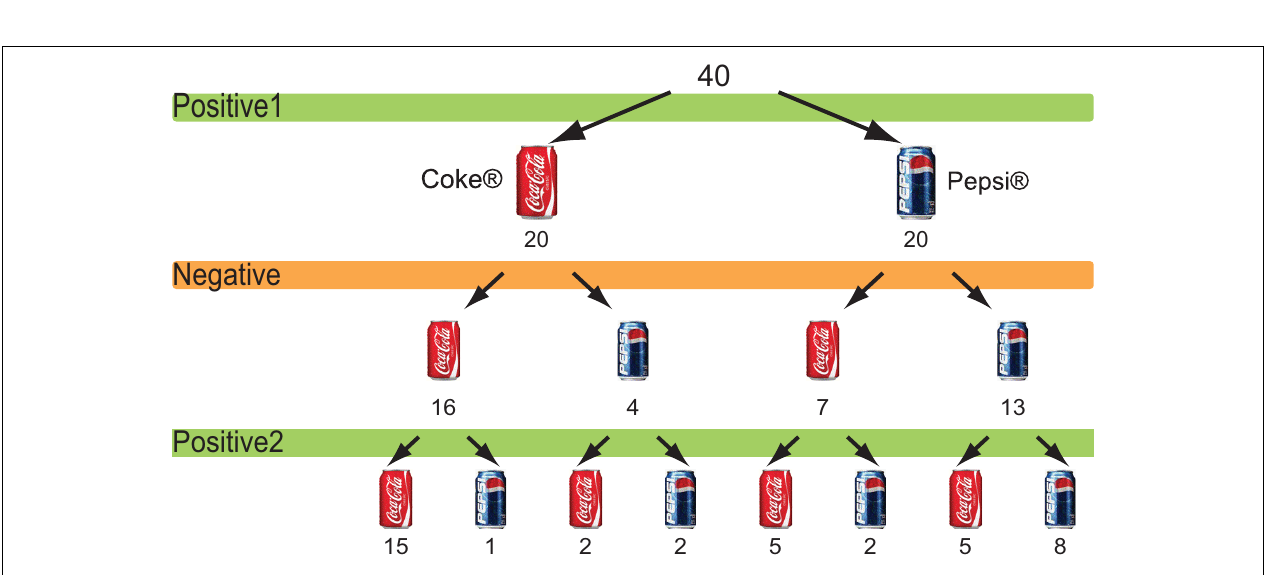
FIGURE 3 | Choice of cola brands. The number of participants who chose either cola brand after each cola advertisement